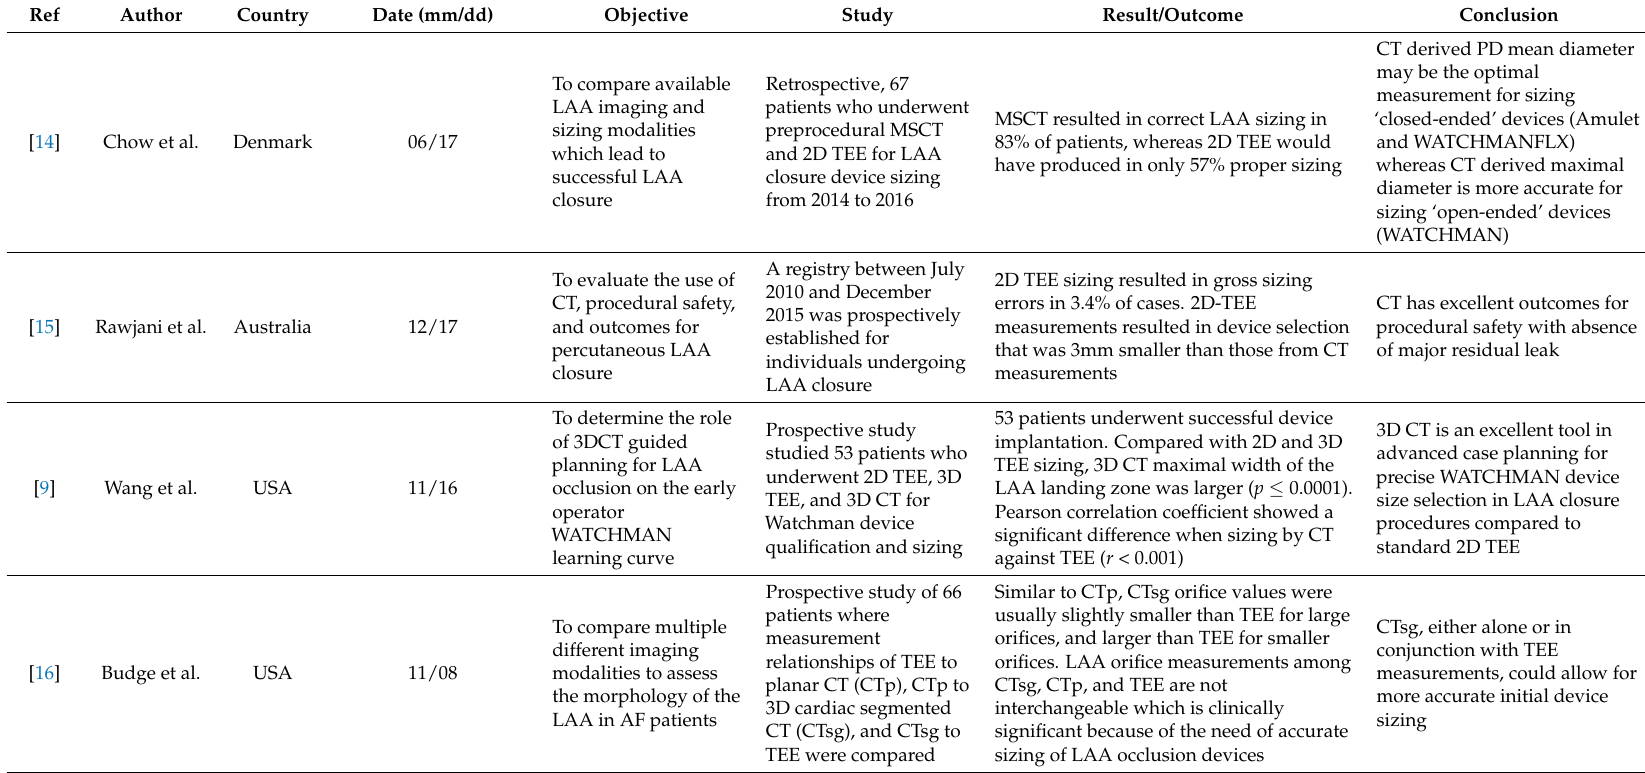
Table 4. Literature review summary table of CT imaging in the preprocedural assessment of the left atrial